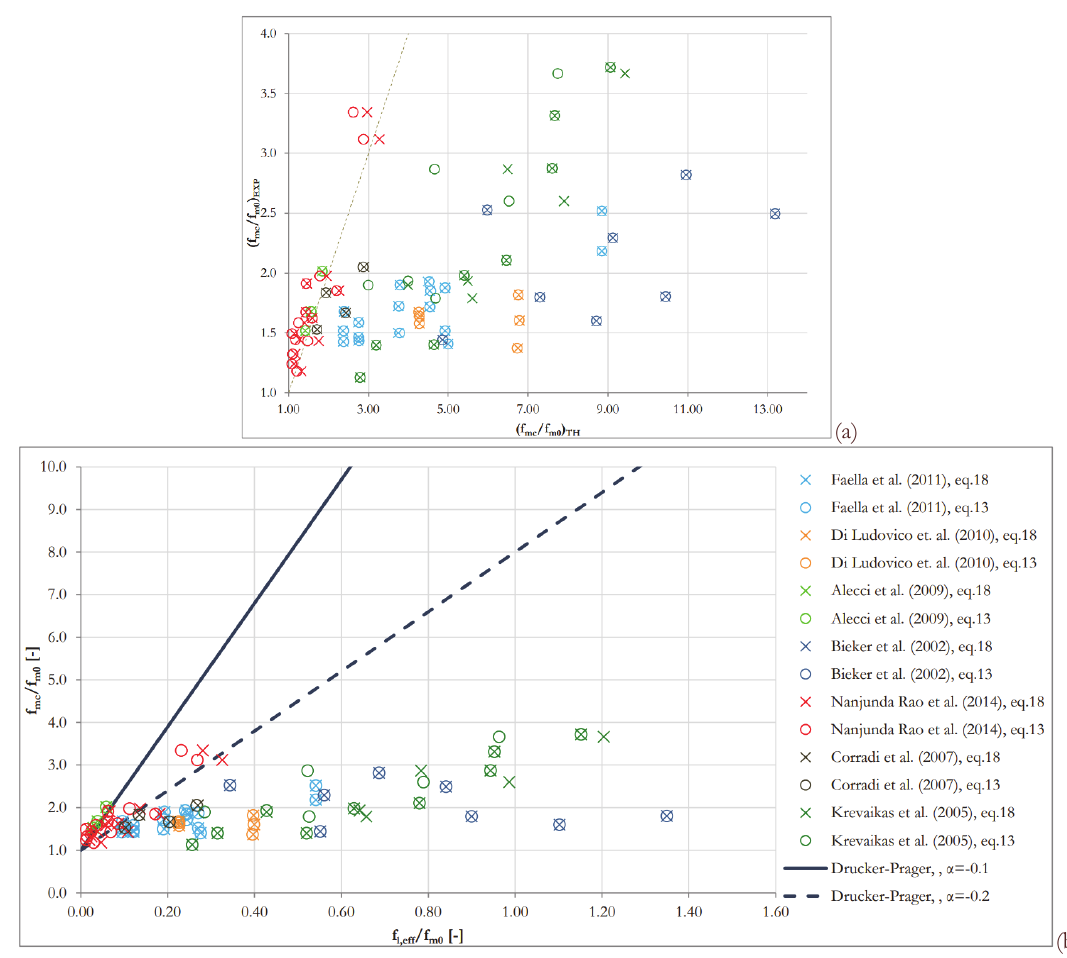
Figure 6: Comparison between experimental results and Drucker-Prager models: a) experimental and theoretical results comparison, b) confinement curve comparison for α =-0.1 (blue solid line) and α =-0.2 (blue dashed